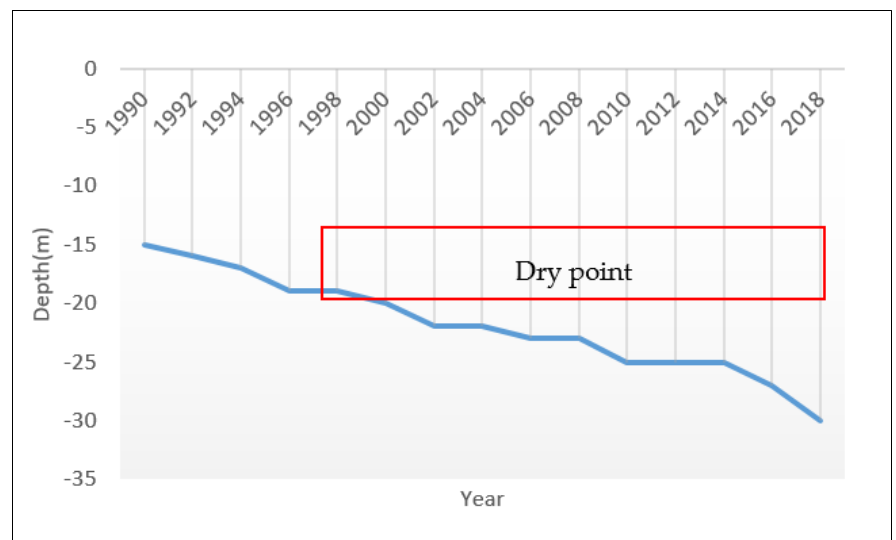
Figure 8. Depth of the water table piezometric surface.